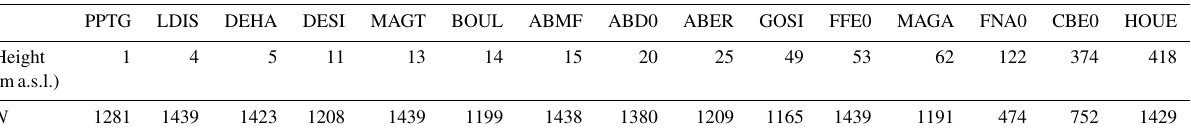
Figure 6. Monthly mean bias (a) and standard deviation of the IWV correction error (b) with the monthly coefficients up to order 5 and WLS. Slope (c) and offset (d) parameters, α c and β c , respectively, of the best linear fit after correction, y i = α c x i, c + β c , as a function of time and height difference. The colour code for time is the same as in Fig. 2. Table 1. Height above sea level and number of IWV estimates ( N ) for 15 GNSS stations over the Guadeloupe archipelago (15.75–16.75 ◦ N, 62–61 ◦ W) for the period from 1 January to 29 February 2020 (Bock et al.,